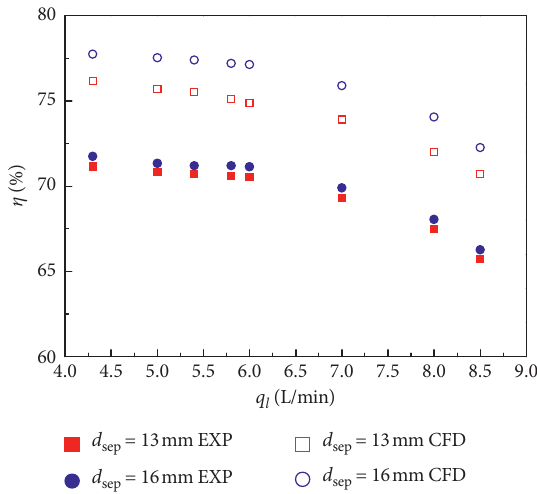
Figure 7: Comparison of calculated value of separator with experimental